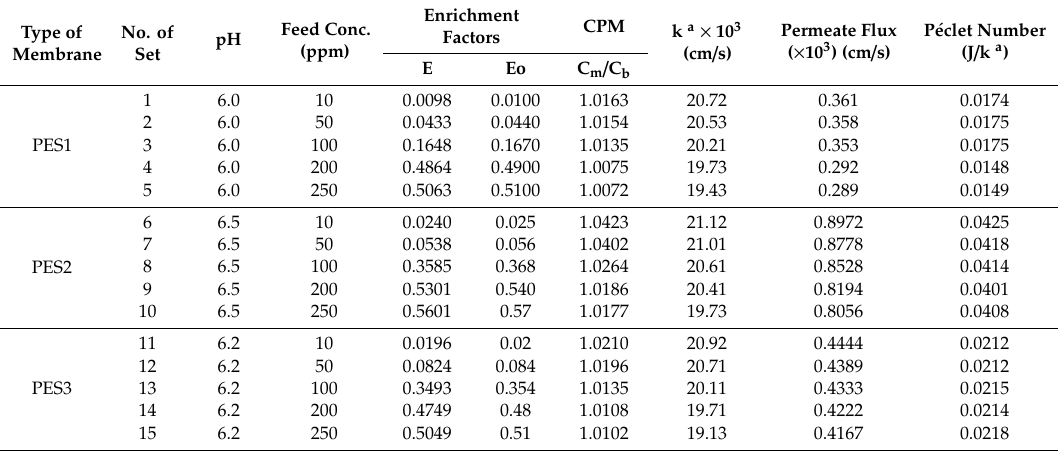
Table 5. Summary of CPM, enrichment factors (Eo and E), and P é clet number (Pb 2 + ). Type of No. of Membrane